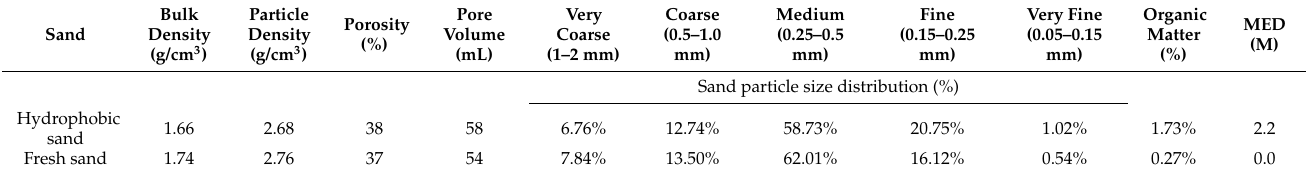
which were equivalent to a pore volume of 58 and 54 mL for hydrophobic and fresh sand columns, respectively (Table 1). Table 1. Summary of hydrophobic and fresh sand properties utilized in this experiment.